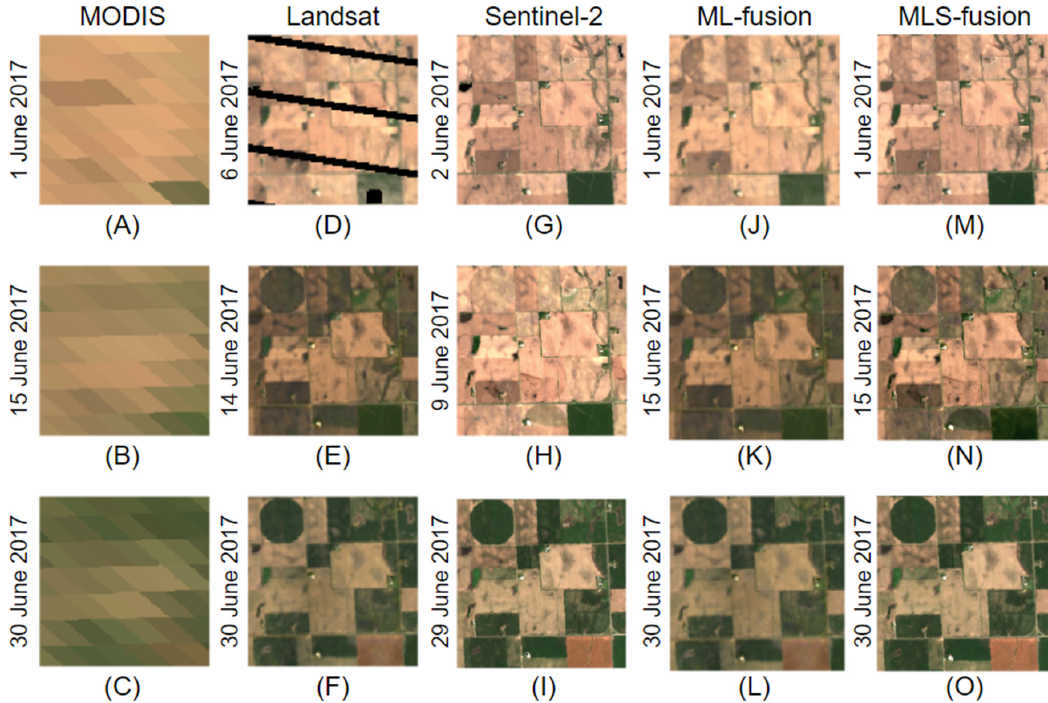
Figure 4. Example of STAIR 2.0 fusion results. STAIR 2.0 is applied to produce the daily time-series with 10-m resolution that covers the growing season (from 1 April to 30 September 2017) of a test region in Saunders, NE in 2017. The input and fused images in June 2017 are shown. (A–C) MODIS images are available every day and three MODIS images on ( A ) 1 June 2017, ( B ) 15 June 2017, and ( C ) 30 June 2017 are shown. (D–F) Three Landsat images are available, on ( D ) 6 June 2017, ( E ) 14 June 2017, and ( F ) 30 June 2017. (G–I) Three Sentinel-2 images are available, on ( G ) 2 June 2017, ( H ) 9 June 2017, and ( I ) 29 June 2017. (J–L) intermediate MODIS–Landsat fusion product (ML-fusion). MODIS and Landsat datasets are fused to generate a daily, 30-m fusion product. Three ML-fusion images on ( J ) 1 June 2017, ( K ) 15 June 2017, and ( L ) 30 June 2017 are shown. (M–O) final MODIS–Landsat– Sentinel-2 fusion product (MLS-fusion). Three MLS images on ( M ) 1 June 2017, ( N ) 15 June 2017, and ( O ) 30 June 2017 are shown. Missing-value pixels due to clouds or Landsat 7 un-scanned strips are shown as black pixels.